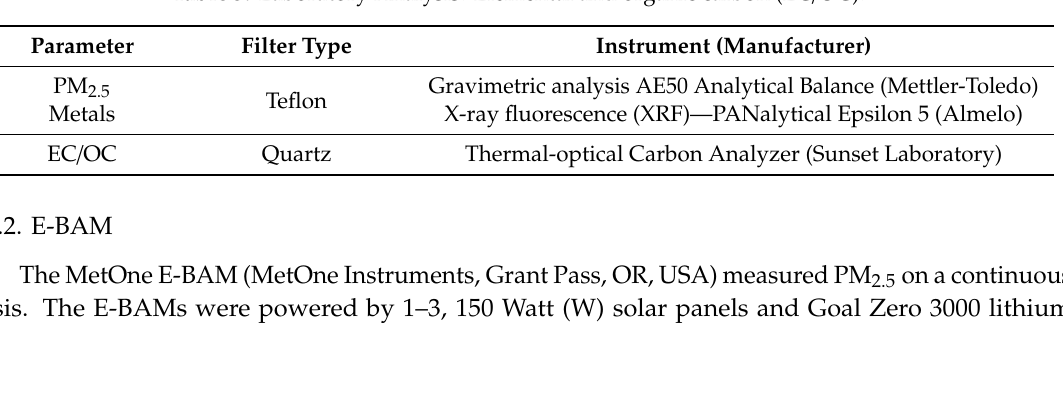
Table 3. Laboratory Analysis. Elemental and organic carbon (EC /